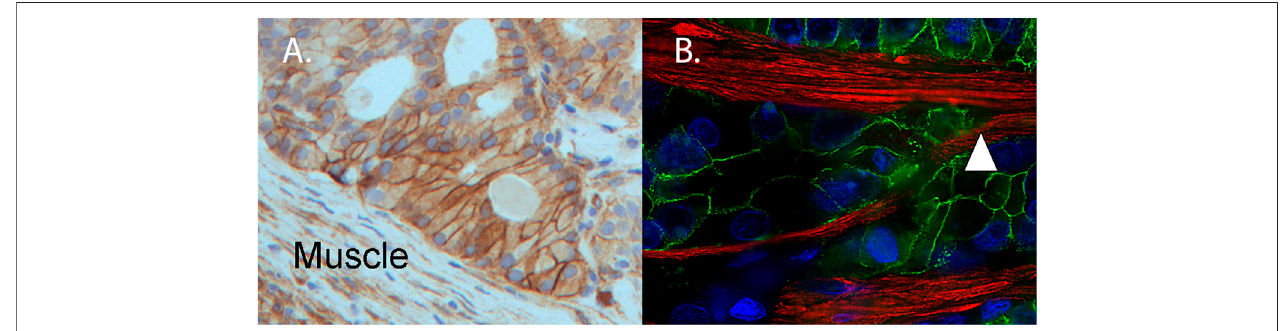
FIGURE 2 | Muscle invasive patient-derived xenograft (PDX) expresses kindlin-2 and angulated invasive clusters of human tumor (from a surgical specimen) splittingthemuscle. (A) ImmunohistochemistryofPDXMDAPCa173-2-4showsexpressionofkindlin-2(brown,DAB)ontumorcellsurfaceofangulatedclusterinvading mouse muscle (Muscle). (B) For comparative purposes, a radical prostatectomy specimen contains angulated invasive human prostate cancer expressing E-cadherin (green), splitting the muscle (white triangle) (desmin, red). Nuclei detected by DAPI (DNA,